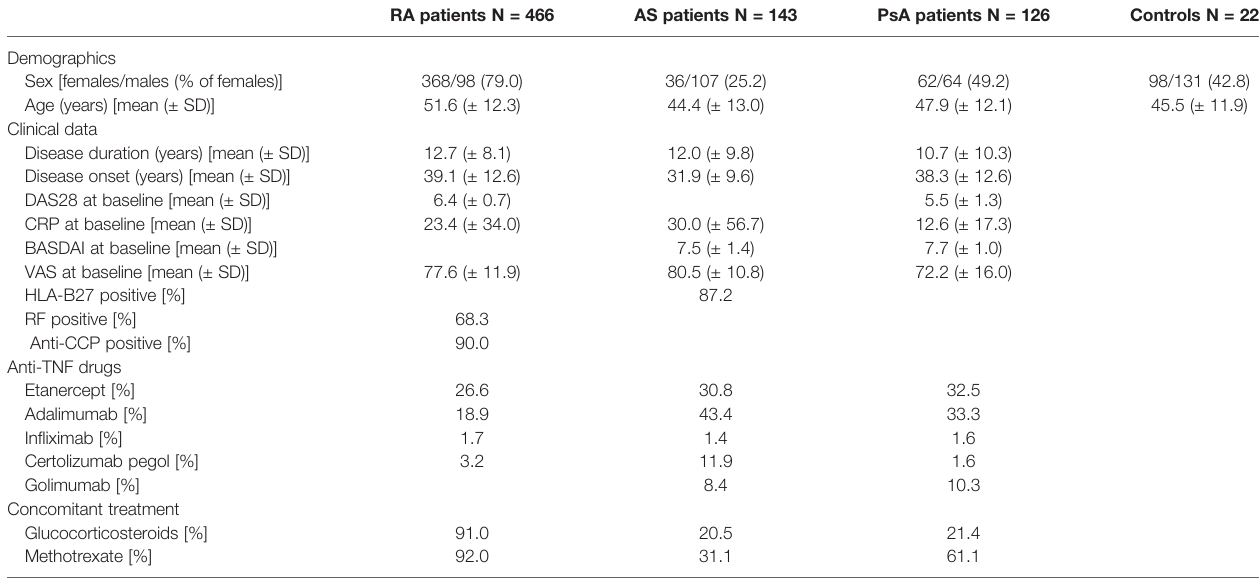
TABLE 1 | Patients ’ and controls ’